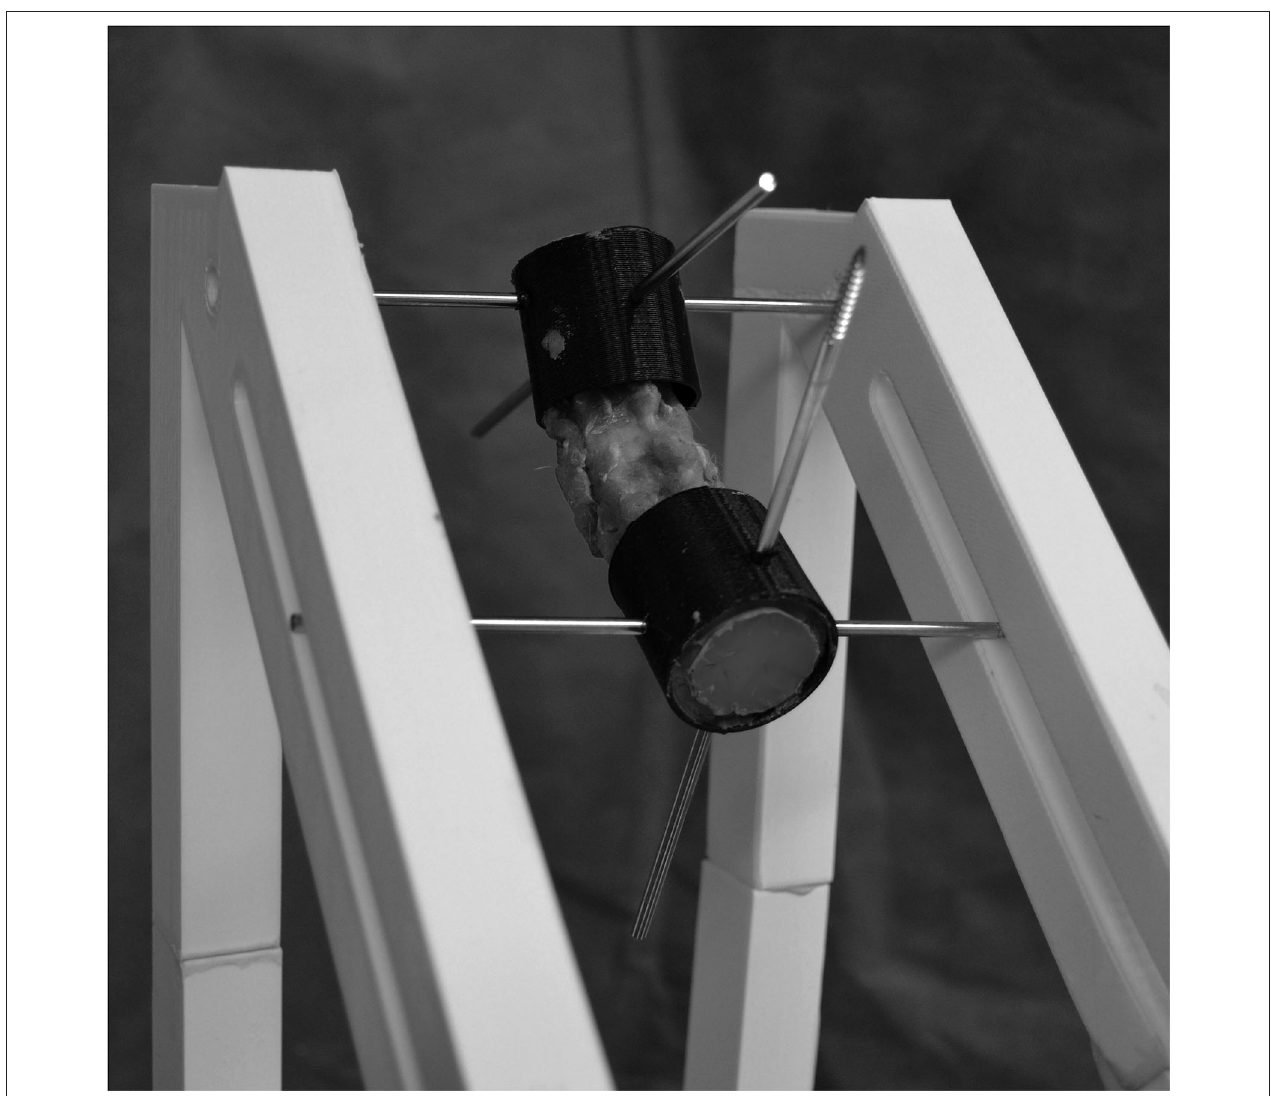
FIGURE 1 | The experimental testing jig for the cervical specimens. Two orthogonal 2.5-mm-diameter Steinman pins were inserted in the transverse and sagittal planes of the potting cylinders. An external skeletal fixator was mounted to maintain different loading positions (neutral, flexion, extension, and lateral bending). Pins in the cranial segment were fixed in a hole in each polyvinylchloride bar, whereas pins in the caudal segment were placed through a slot to direct the applied torque to one